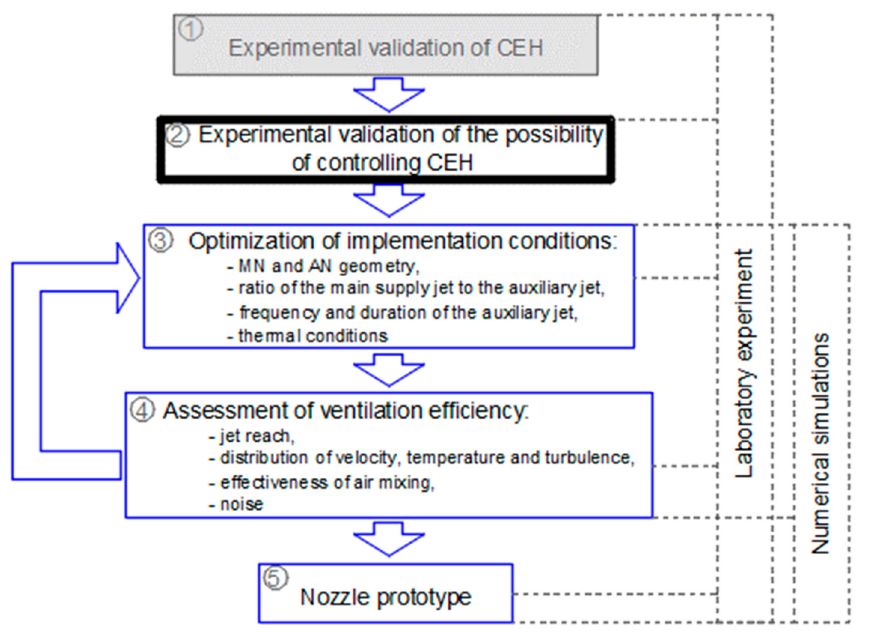
Figure 3. Flow chart presenting successive research tasks in the process of designing an unsteady ventilation system based on CEH.